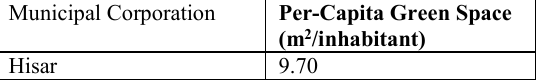
Table 5: Per-capita green space for different Municipal Corporation